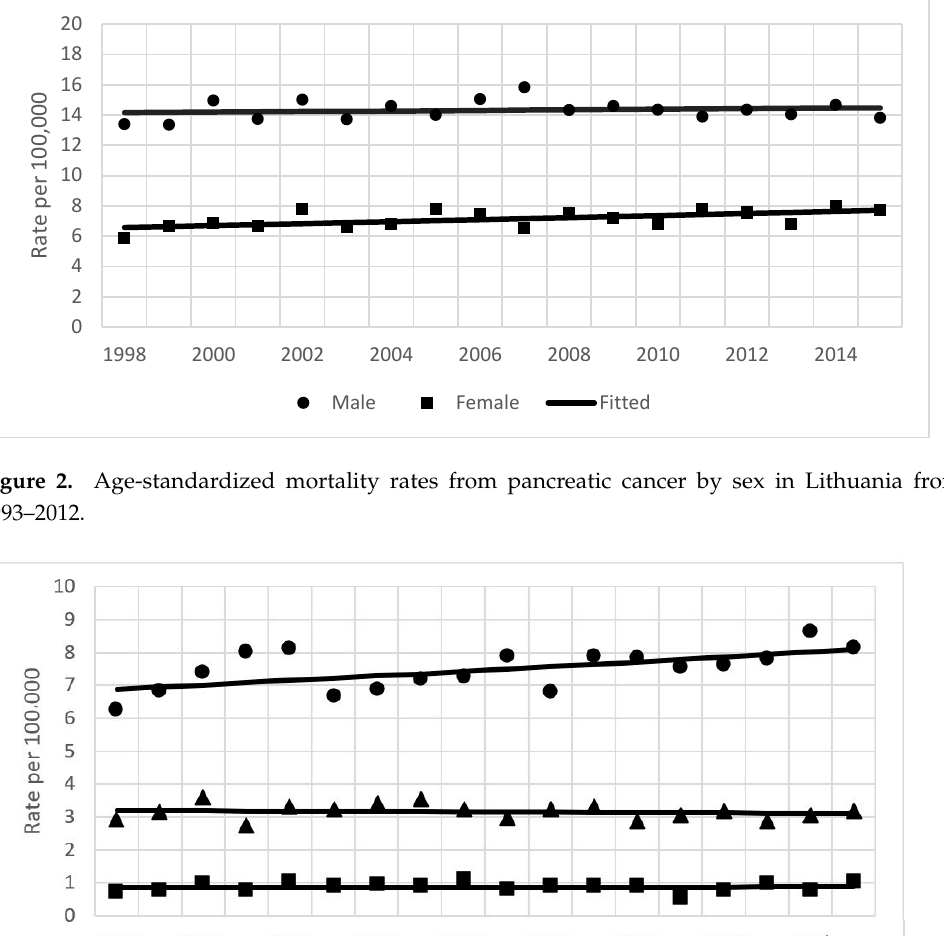
Figure 1. Age-standardized incidence rates of pancreatic cancer by sex in Lithuania from 1998–2015.